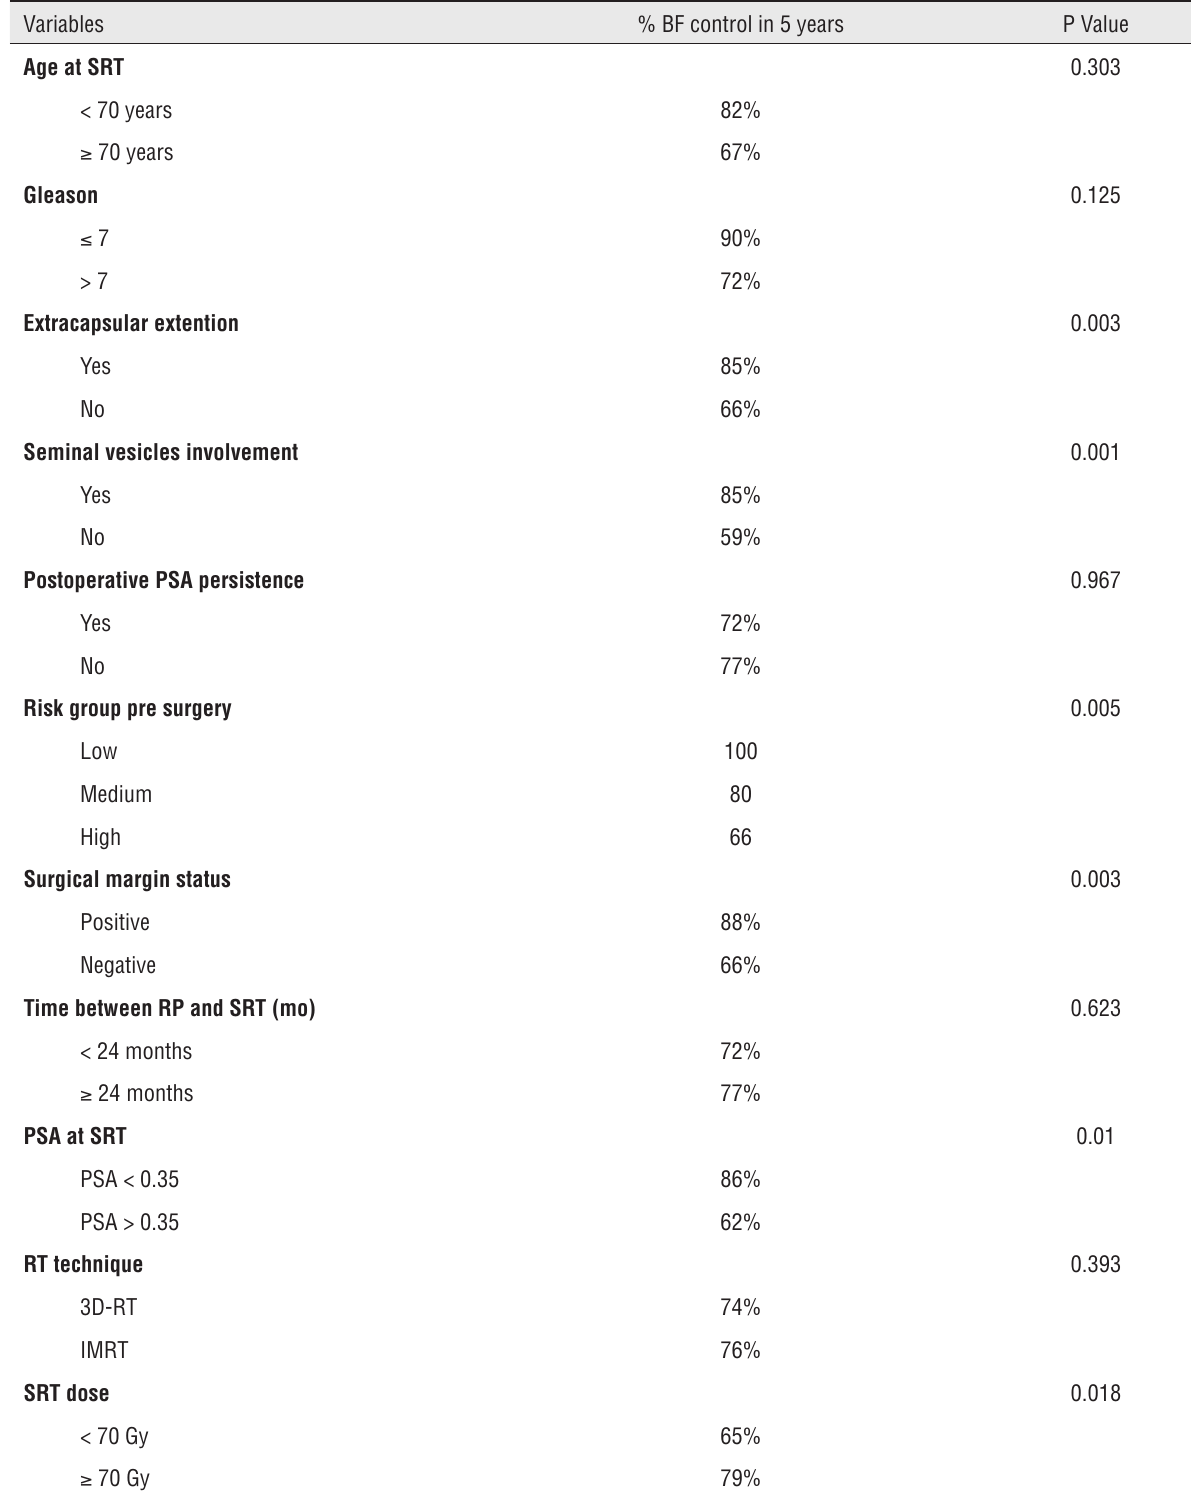
Table-2 - Univariate analysis of factors related with biochemical recurrence (BCR) after salvage radiotherapy (SRT). Variables % BF control in 5